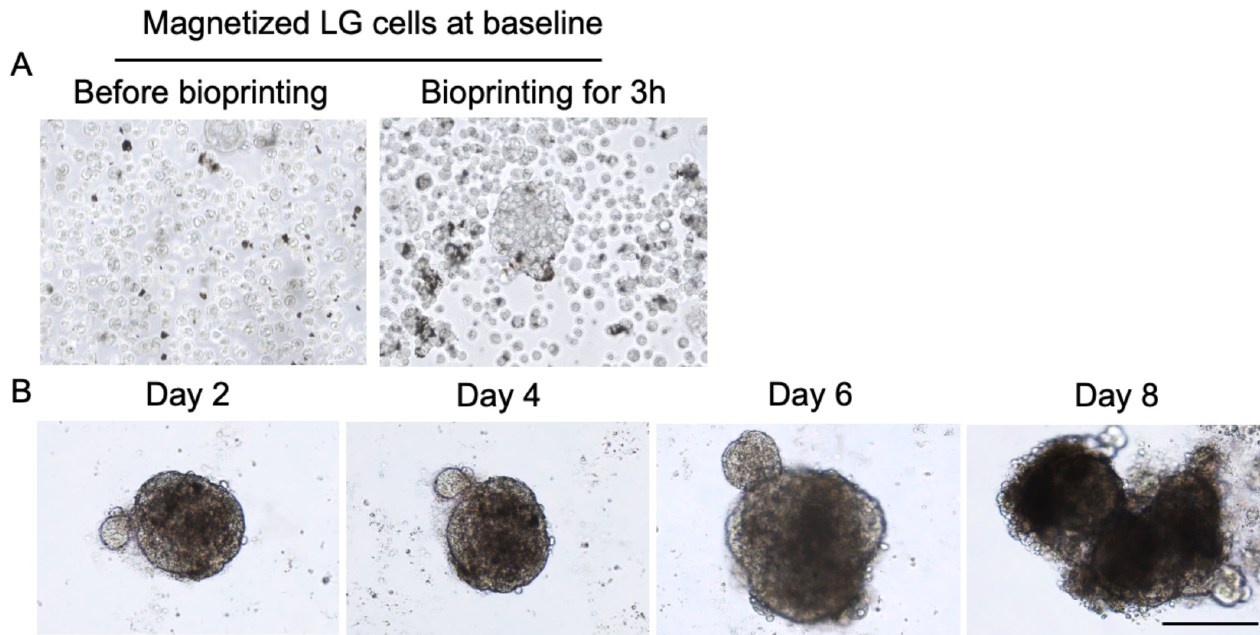
Fig 4. Micrograph morphologies of cells or organoids from LG 2D culture system to organoid stages. Differentiated LG cells in 2D were magnetized with magnetic nanoparticle solution (MNP) and then 3D assembled by M3DB (A). Organoids were cultured and their morphology was profiled via light microscopy and high throughput scanning analysis for 8 days. Scale bar: 200 μ m.